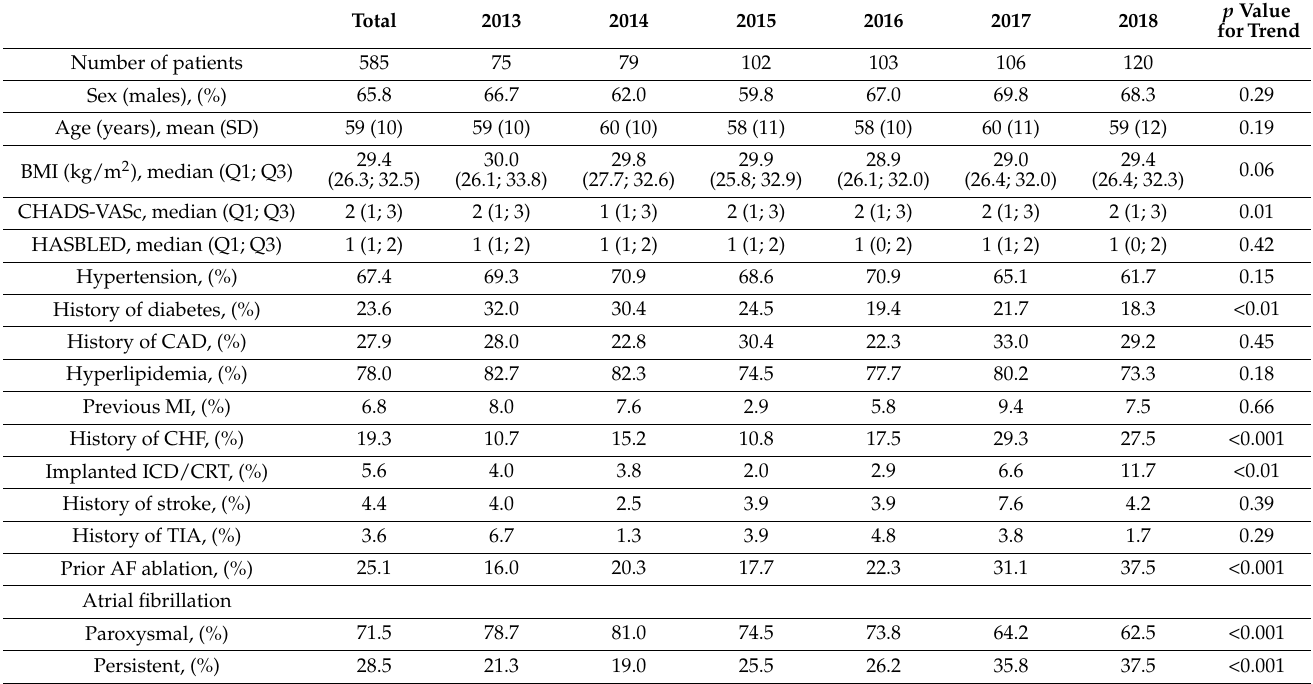
Table 1. Baseline characteristics.